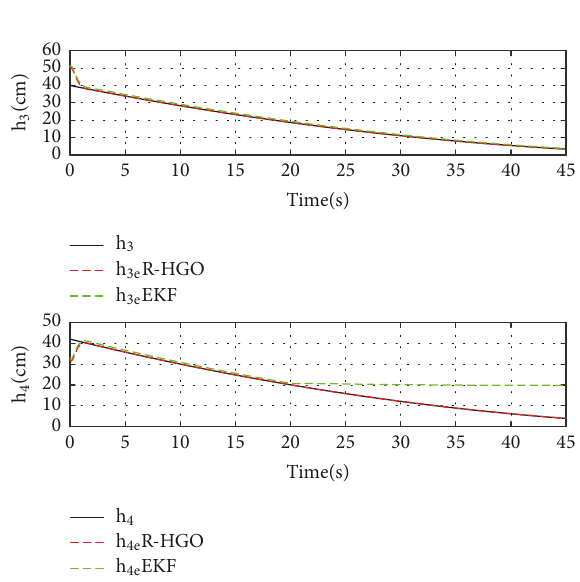
Figure 2: Estimation of the liquid levels ℎ 1 and ℎ 2 .